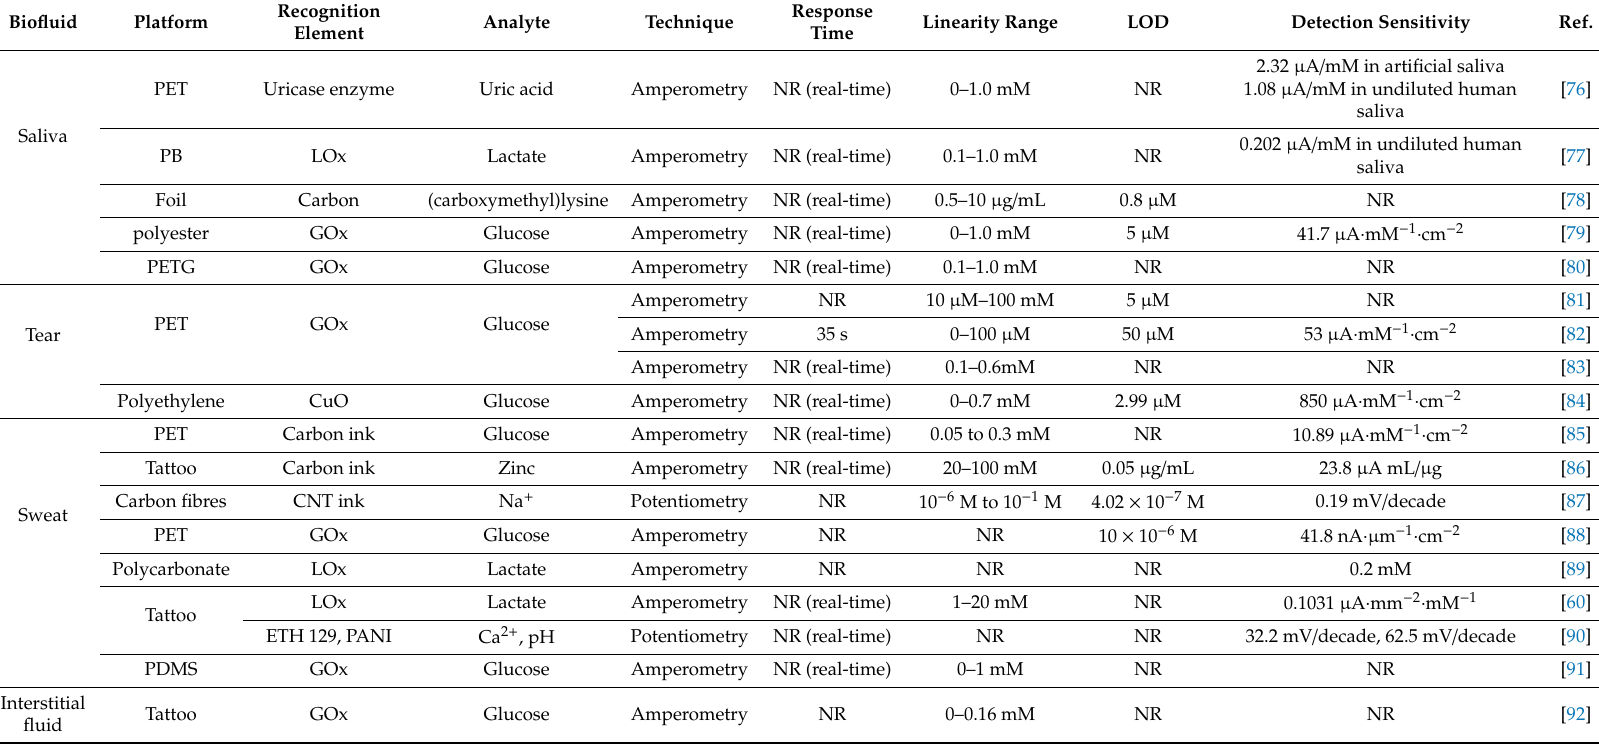
Table 2. Summary of representative electrochemical biosensors with applications of biofluid